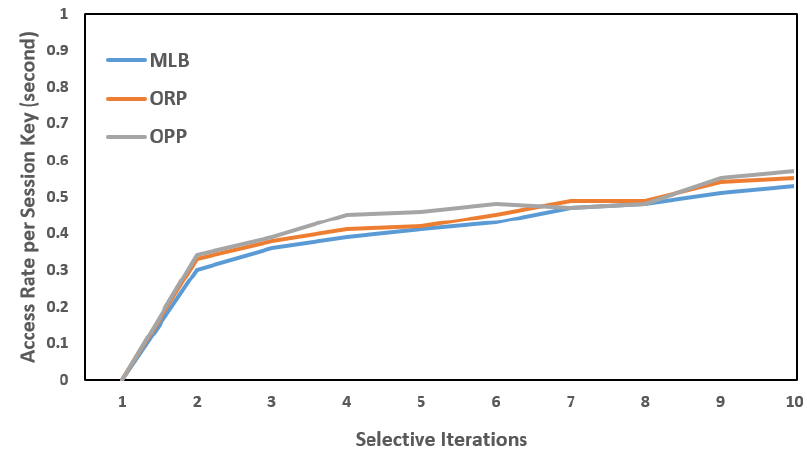
Figure 6. AV access rates per session key: key session = 2 s; time period = 10 min.